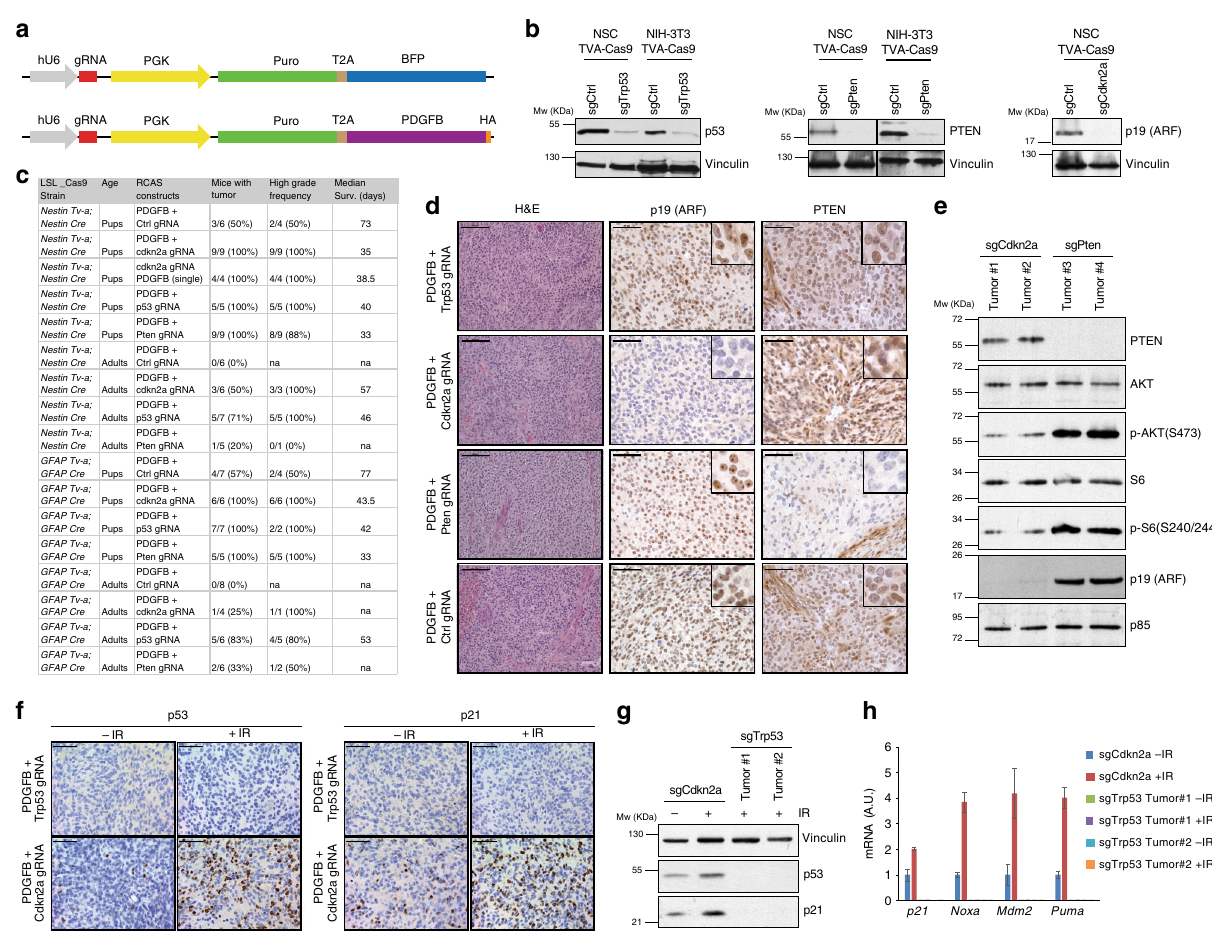
Fig. 2 Tumor suppressor genes knockout by RCAS-gRNA plasmids induce high-grade-gliomas. a Schematic illustration of the RCAS-gRNA plasmids. b In vitro validation of the RCAS-gRNA against Trp53 , Pten, Cdkn2a and a non-targeting control (Ctrl). Western blot analysis, using the indicated antibodies, on whole cell extracts from NIH-3T3 TVA-Cas9 fi broblasts and Ntv-a; LSL-Cas9 neural stem cells (NSCs) transduced with pMSCVhygro-CRE (NSC TVA- Cas9). To induce p53 expression, the cells were collected 24 h after exposure to ionizing radiation (10 Gy). c Table summarizing the injections performed in the Ntv-a; Nes-Cre; LSL-Cas9 and Gtv-a; hGFAP-Cre; LSL-Cas9 pups and adult mice. Co-injection of RCAS-PDGFB and the RCAS-gRNA against different tumor suppressor genes accelerate tumor formation, increases the tumor penetrance and the frequency of high-grade gliomas. d Hematoxylin and eosin (H&E) and immunohistochemical stainings (IHCs), using the indicated antibodies, of representative RCAS-PDGFB/gRNA tumors. To note PTEN expression in the normal vasculature but not in the tumor cells of the RCAS-PDGFB + RCAS-Pten-gRNA tumor. Insets show higher magni fi cation images. Scale bars: H&E 100 μ m; IHCs 50 μ m. e Western blot analysis, using the indicated antibodies, on whole cell extracts from tumorspheres. f IHCs for p53 (left panels) and p21 (right panels) on the indicated tumors 1 h after exposure to 10 Gy IR. Scale bars: 50 μ m. g Western blot analysis, using the indicated antibodies, on whole cell extracts from tumorspheres 24 h after exposure to 10 Gy IR. h Quantitative real-time PCR (qPCR) analysis on mRNA extracted from tumorspheres 3 h after exposure to 10 Gy IR. Data presented as mean ± SD ( n = 3); A.U. arbitrary presented no abnormalities in development and size (Supple- mentary Fig. 1a), were fertile and had normal litter sizes.